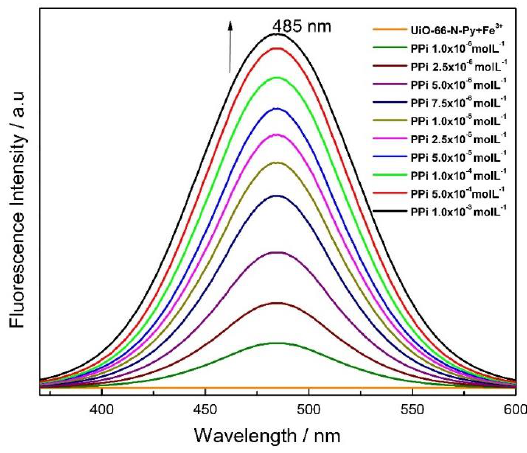
Figure 8. Changes in fluorescence emission spectra of UiO-66-N-Py + Fe 3+ with the incremental addition of PPi (10 −2 M) in water (λ exe = 341 nm).